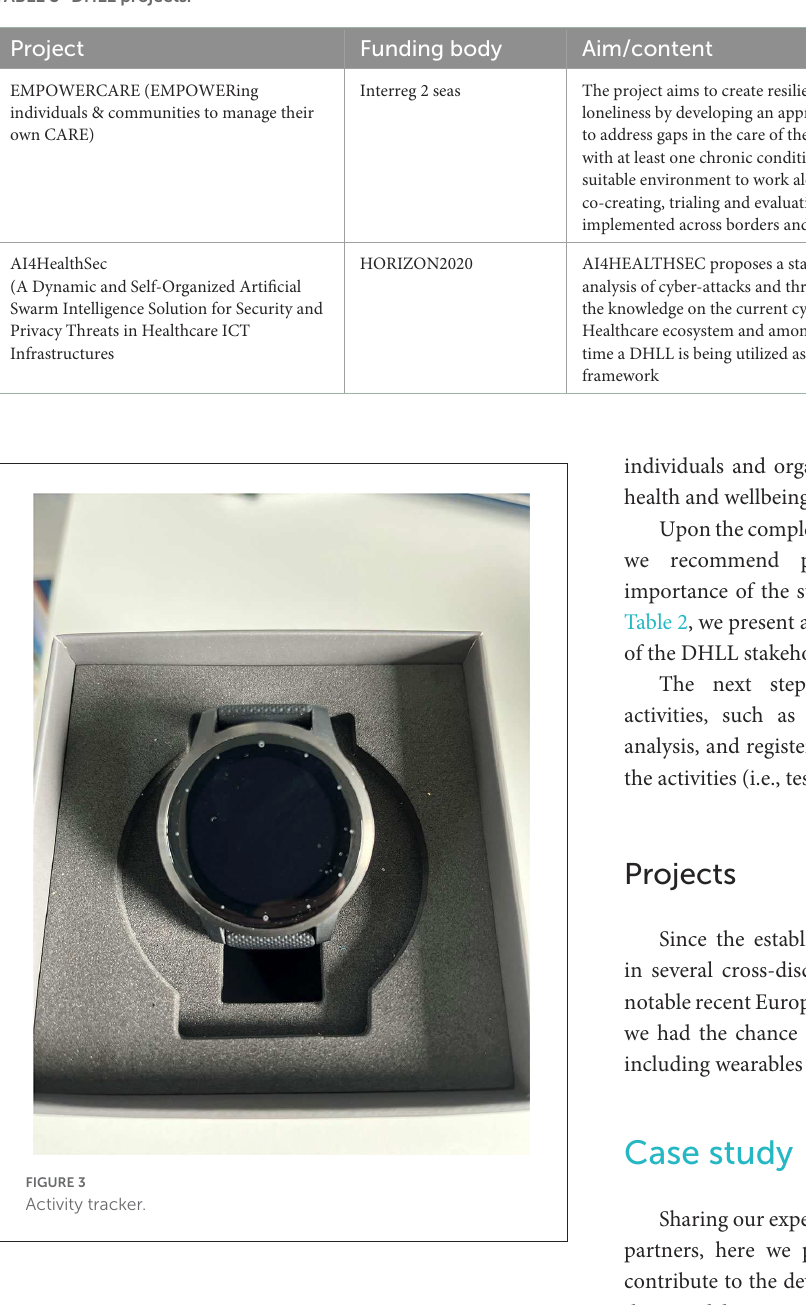
TABLE 3 DHLL projects.